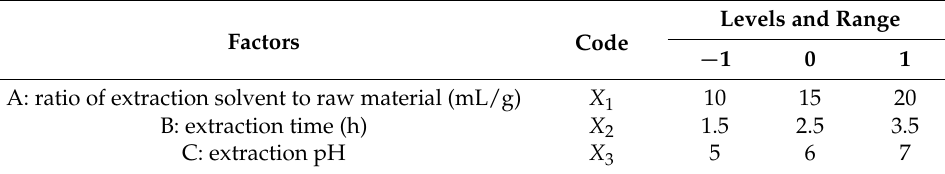
Table 1. Independent variables and their levels used for Box–Behnken design (BBD).